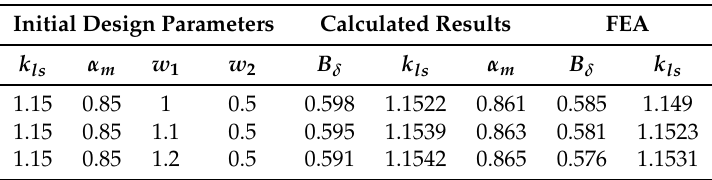
Table 3. Calculated results and FEA results.